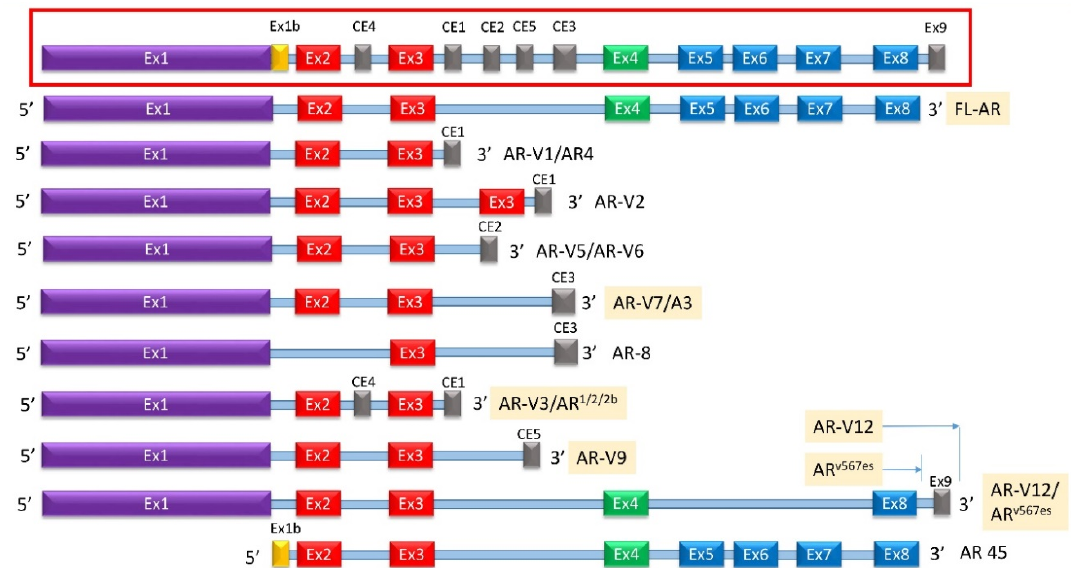
Figure 5. Known AR-Vs Lacking Specific Domains. ( Inset ) A simplified schematic of the gene encoding for AR with designated cryptic and canonical exons as well as intronic sequences known to be integrated into alternatively spliced AR protein products. ( Main ) The subset of AR-Vs known to lack the LBD are shown above with the translated sequences represented on the left and the name(s) of the correlating variant on the right. All known AR-Vs lacking the LBD do contain the full NTD and at least one exon of the canonical DBD. Of note, AR-V5 and AR-V6 are distinct variants that contain different translated 3 ′ sequences of CE2. CE: cryptic exon, CTD: C-terminal domain, DBD: DNA-